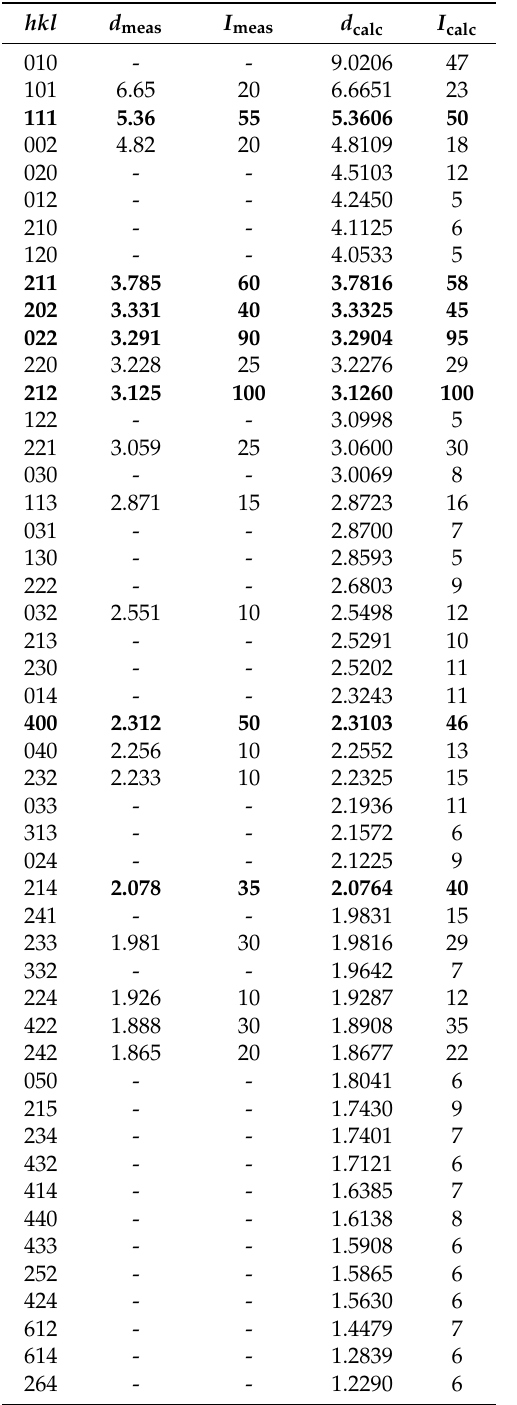
Table 4. Measured and calculated X-ray powder diffraction data ( d in Å) for quijarroite. The strongest diffraction lines are given in